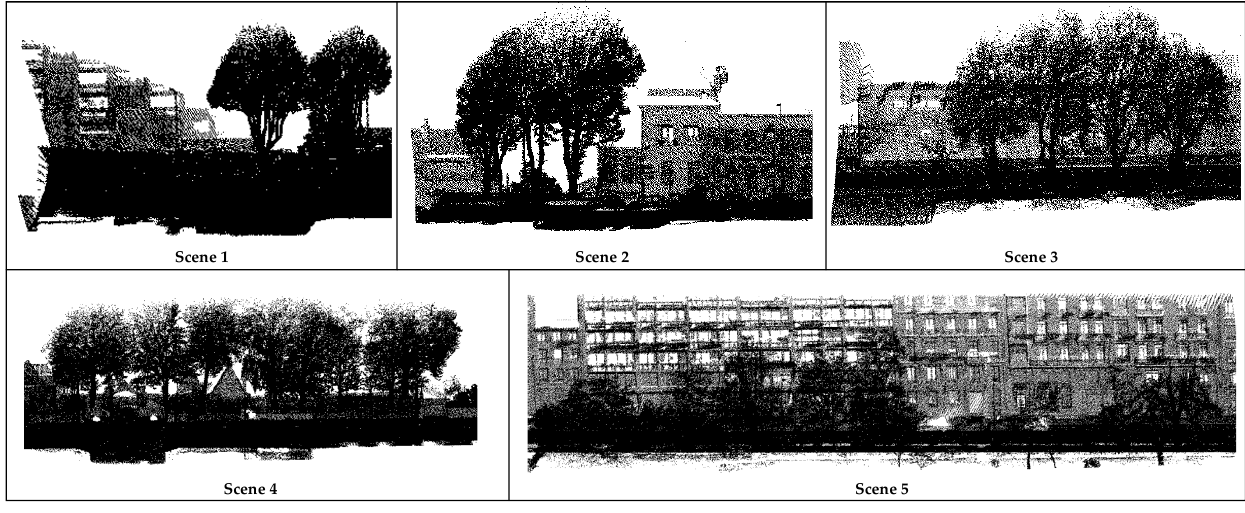
Figure 8. The raw PCD of five scenes.